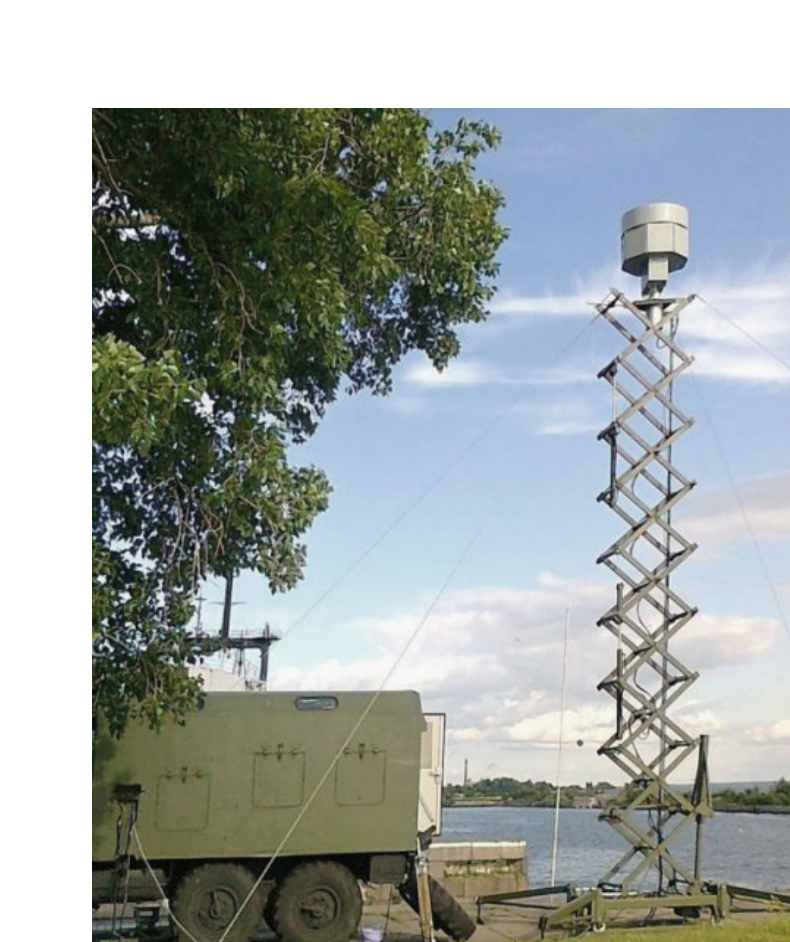
Senzor Vektor ima antenu na kojoj se nalazi osam mrežnih podsklopova a nosi je uspravna platforma. Upotrebljavaju ć i dve ili više jedinica, odvojenih odre- đ enom razdaljinom, sistem može locirati emisije upotrebljavaju ć i kao procesorski faktor razliku u vremenu pristizanja emisija i može locirati cilj u „jednom ili dva pulsa“. Kompanija kaže da senzor može locirati avion AWACS na daljini od 800 km, krstaricu za protivvazdušnu borbu na daljini od 220 do 400 km i podmornicu koja prenosi podatke putem datalinka na daljini od 30 do 90 km. Mobilna verzija sistema na kamionu je uvedena u rusko naoružanje tokom 2002 godine a sada je nasle đ uje verzija za koju se tvrdi da omogu ć ava otkrivanje daljine cilja sa 10 procenata ta č nosti upotrebljavaju ć i samo jednu stanicu. Na č in na koji se ovo postiže nije otkriven. Sistem primarno upotrebljava emisiono zra č e- nje cilja ali može tako đ e raditi i u bistati č nom modu u koordinaciji sa drugim odaši- lja č ima kao što su drugi radari ili TV stanice. Sli č an sistem je prikazan na aeromi- tingu u formi modela a tim sistemom se upravo opremaju ruske snage. Dragan Vu č kovi